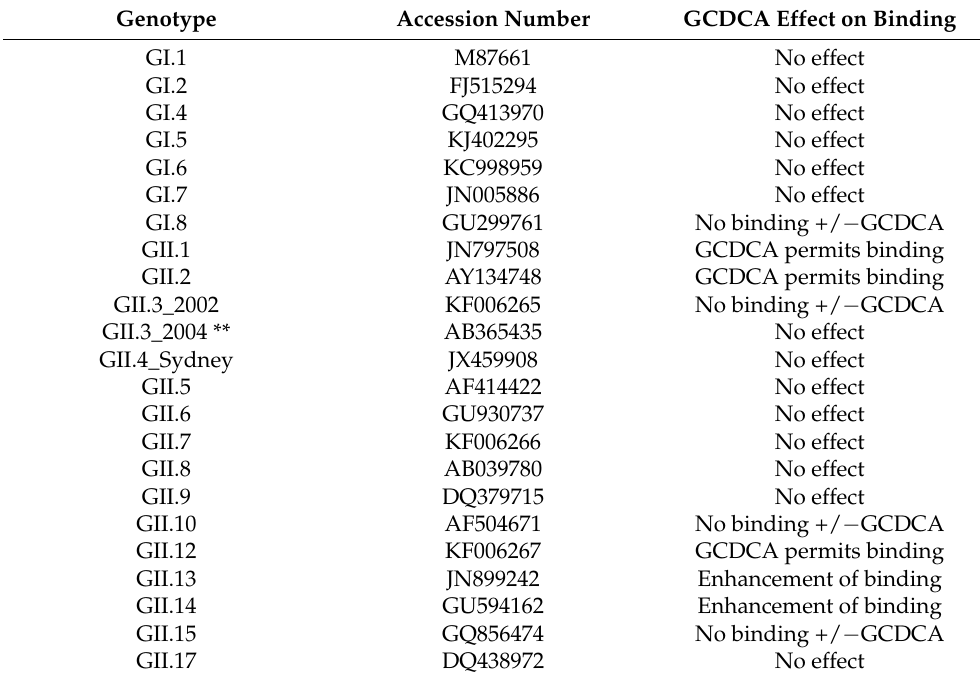
Table 2. Effect of BA treatment on VLP * binding to PGM.